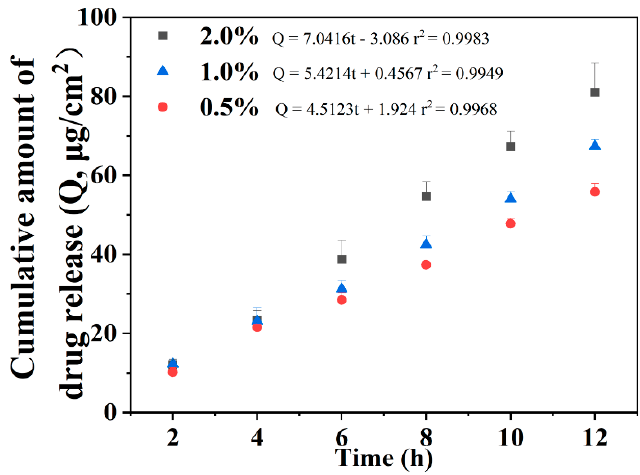
Figure 4. Effects of AA content on the release of AA.